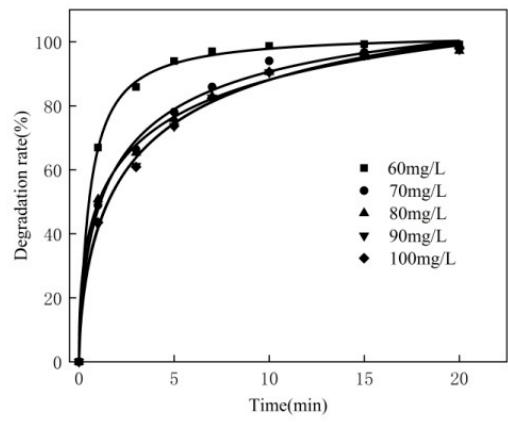
Figure 5. Effect of MB concentration.